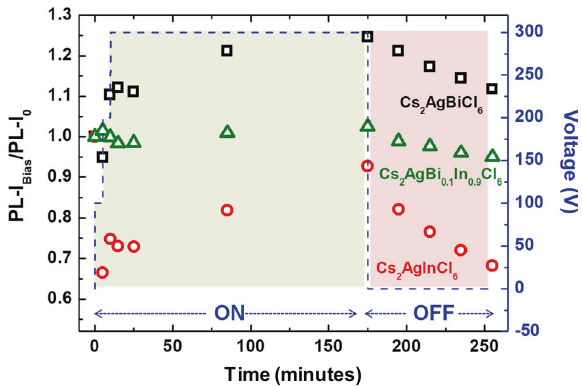
Fig. 8 Bias-dependent emission spectra. Ratio of integrated photoluminescence intensity measured under biased voltages to photoluminescence intensity measured before applied voltage as the function of time is plotted for CAIC, CABC, and Bi 0.10 In 0.90 compounds. The void black-colored squares represent the CABC, void green-colored triangle represents the Bi 0.10 In 0.90 , and void red-colored circle represents the CAIC